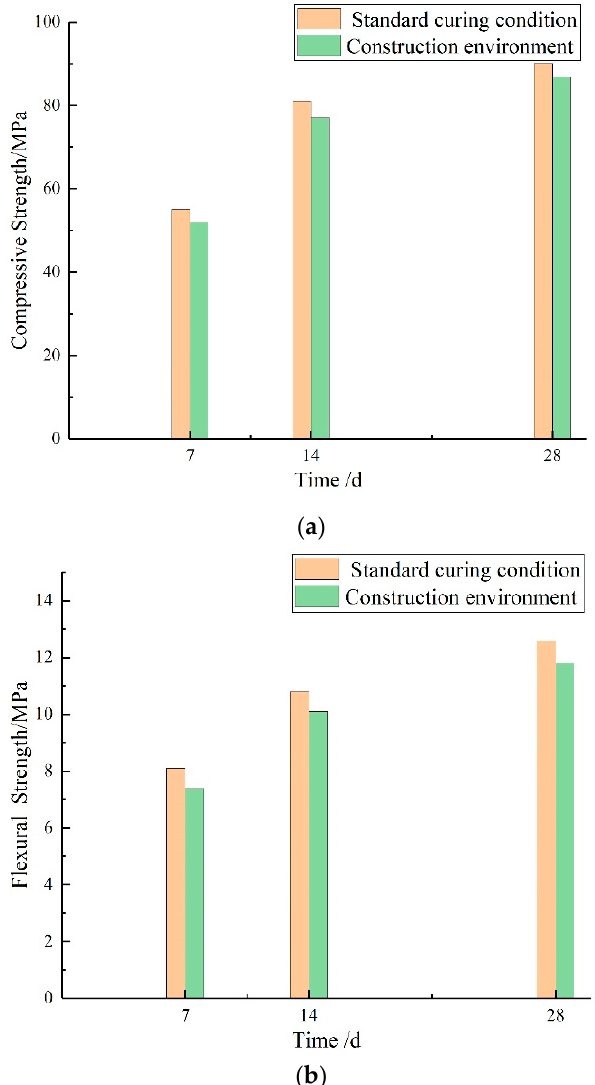
Figure 12. Compressive and flexural strength of H-70; ( a ) compressive strength; ( b ) flexural strength.